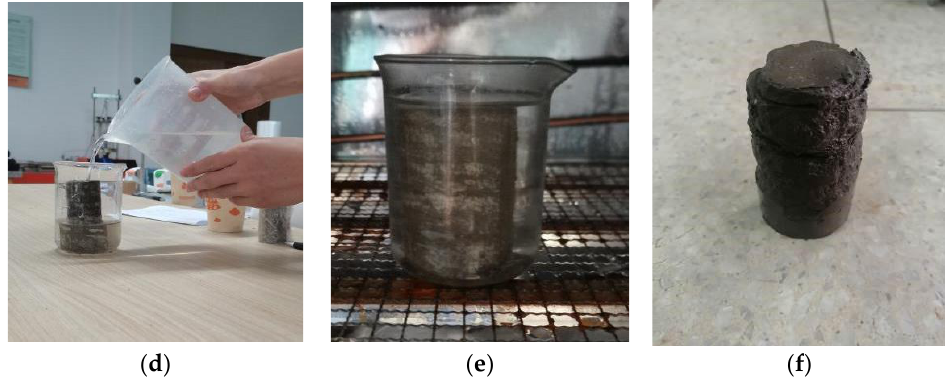
Figure 7. Dry – wet cycle operation of ( a ) 24 h in circumstances of 60 ± 3 °C, ( b ) temperature setting, ( c ) constant temperature curing, ( d ) adding water, ( e ) constant temperature and humidity curing, and ( f ) surface observing.